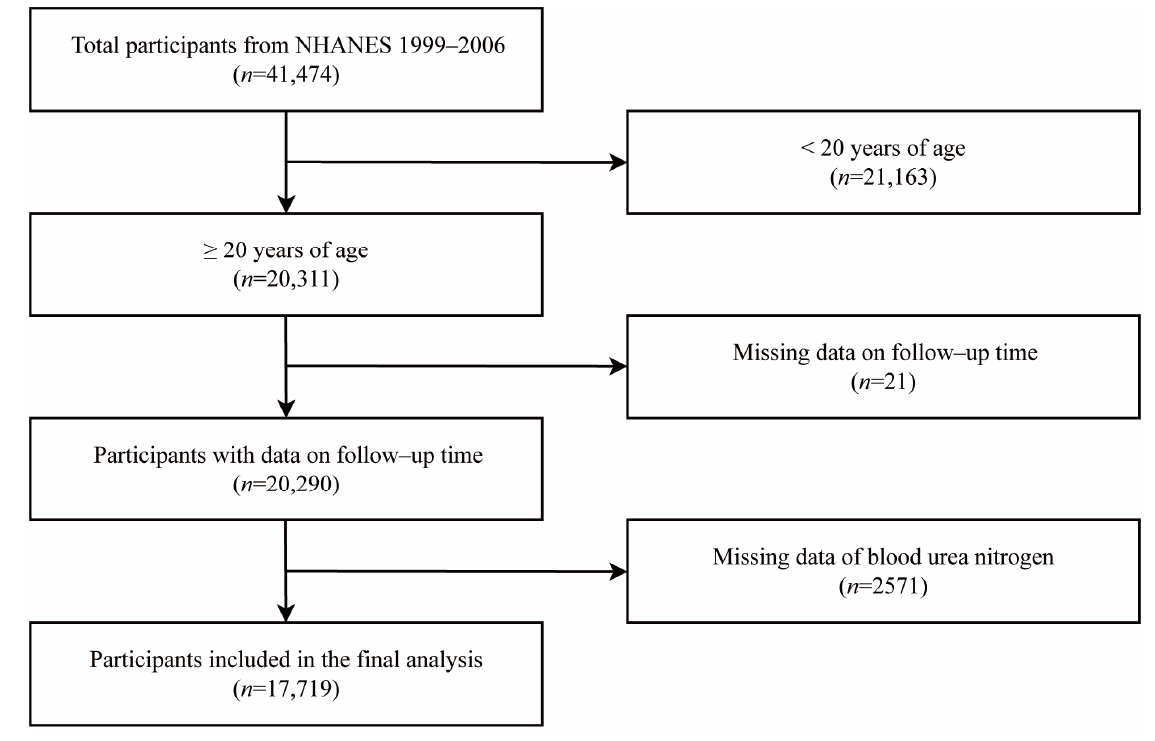
Figure 1. Flowchart of participants included in the analysis.